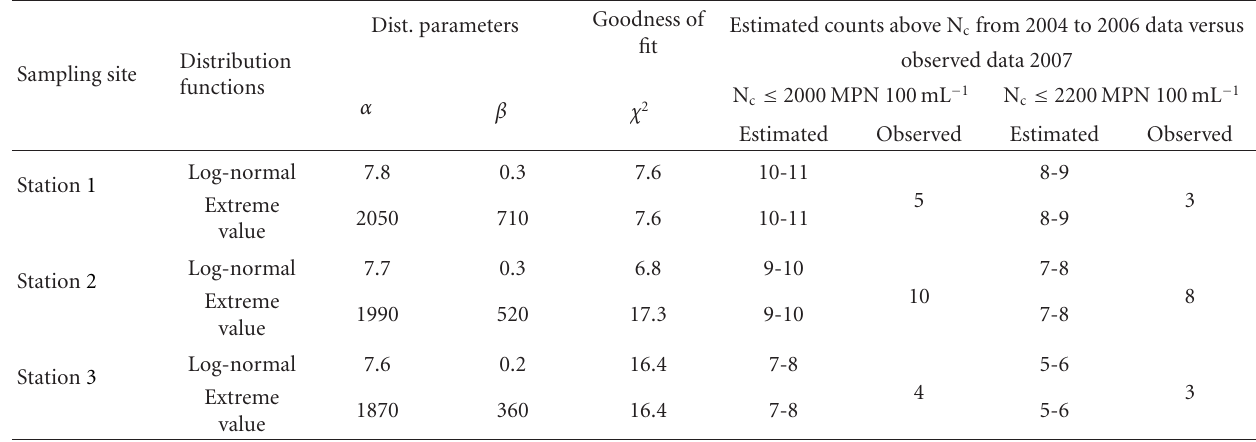
Table 2: Parameters, goodness of fit measure and estimated probability of total coliforms above specified values for each distribution function versus observed frequencies at each sampling site.